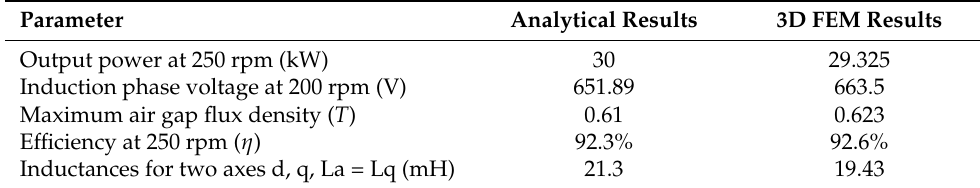
Table 6. Comparison between analytical results and 3D FEM results.